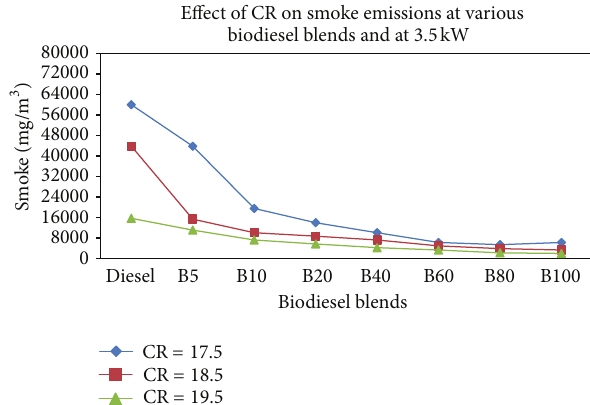
Figure 8: Variation in EGT for various biodiesel blends at different loads.